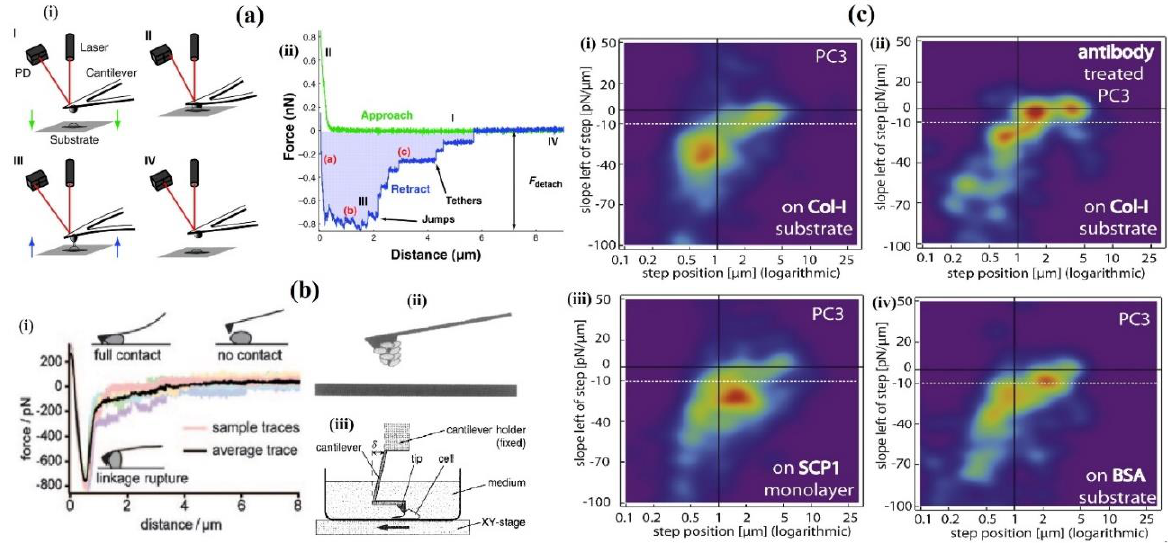
Figure 7. Atomic force microscopy. ( a ) Depiction of a cell-adhesion measurement ( i ) for which characteristic approach (green) and retraction (blue) traces are shown ( ii ). ( i ) In this technique, the cell and the substrate are brought into contact (aiI). The substrate that is probed can be another cell, a functionalized surface, or an organic matrix. The position on a photodiode (PD) of a laser beam (red line) that is reflected off the back of the cantilever measures the deflection of the cantilever and thus the force that acts on the cantilever. During the approach (denoted by green arrows), the cell (probe) is pressed onto the substrate until a pre-set force (usually <1 nN) is reached (aiII). After a contact time ranging from 0 to 20 min, the cell is retracted from the substrate (marked by blue arrows), and a force-distance curve is recorded (aii). This curve corresponds to a cell-adhesion signature as the strain on the cell increases. These bonds have been formed between the substrate and the cell break sequentially (aiIII) until the cell has wholly separated from the surface (aiIV). The maximum downward force exerted on the cantilever of the atomic force microscope is referred to as the detachment force (F detach ). During the separation of the cell from the surface, two types of molecular unbinding events can occur. In the first event, the receptor remains anchored in the cell cortex and unbinds as the force increases (denoted as jumps). The second type of unbinding event occurs when receptor anchoring is lost and membrane tethers are pulled out of the cell. In the unbinding-force–distance curve, long plateaus of constant force characterize tethers. The shaded area in ( ii ) represents the measured work of cell detachment from the substrate. The lower-case letters (a, b and c) denote different phases of cell-substrate detachment. Steps I–IV shown in ( i ) are also indicated in ( ii ). (Reproduced with permission from [65]) ( b ) Atomic force microscopy (AFM) measurement of de-adhesion force. ( i ) Six sample traces for a single-cell are shown in shades of grey, with the average trace shown in black. At zero distance, the cell is in full contact with the cantilever, which is applying a positive force. As distance increases, the cantilever is pulled away from the glass slide surface, causing the cell–cantilever linkage to rupture and result in the zero-force, no-contact region. The force of de-adhesion was calculated as the difference between the curve minimum and the horizontal no-contact region. ( ii ) Cells-coated tips of AFM cantilever probing planar substrate. ( iii ) Principle of the measurement of a cell adhesive shear force to a material. The cell is detached from the bottom of the dish, having been applied a lateral force by the tip of the cantilever. The magnitude of the shear force applied to the cell is given as the product of the force constant of the cantilever and the deflection of the cantilever (δ). (Reproduced with permission from [68–70]). ( c ) Two-dimensional probability density plots of human prostate cancer (PC3) cells interacting specifically with collagen-I (Col-I) ( i ) and bone marrow-derived stem cell monolayer (SCP1) cells ( iii ) and nonspecifically with bovine serum albumin (BSA) ( iv ). ( ii ) PC3 cells treated with monoclonal antibody to CD29/integrin β 1 also interact nonspecifically with Col-I. (Reproduced with permission from